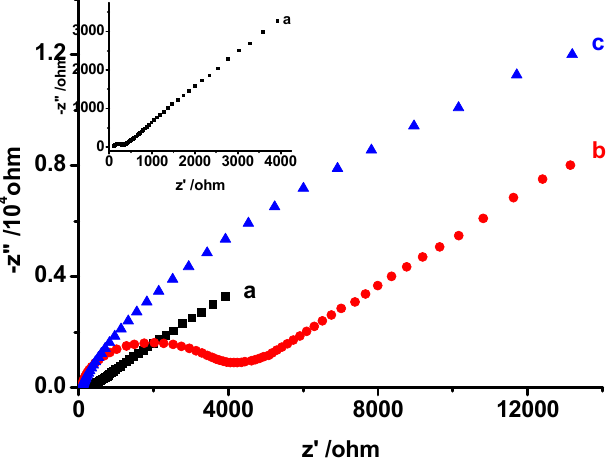
Figure 5. Electrochemical impedance spectroscopy (EIS) of different electrodes in 5.0 mmol·L − 1 K 3 [Fe(CN) 6 ] with 0.1 mol · L − 1 KCl: ( a ) bare electrode; ( b ) MIP/Au; ( c ) NIP/Au.